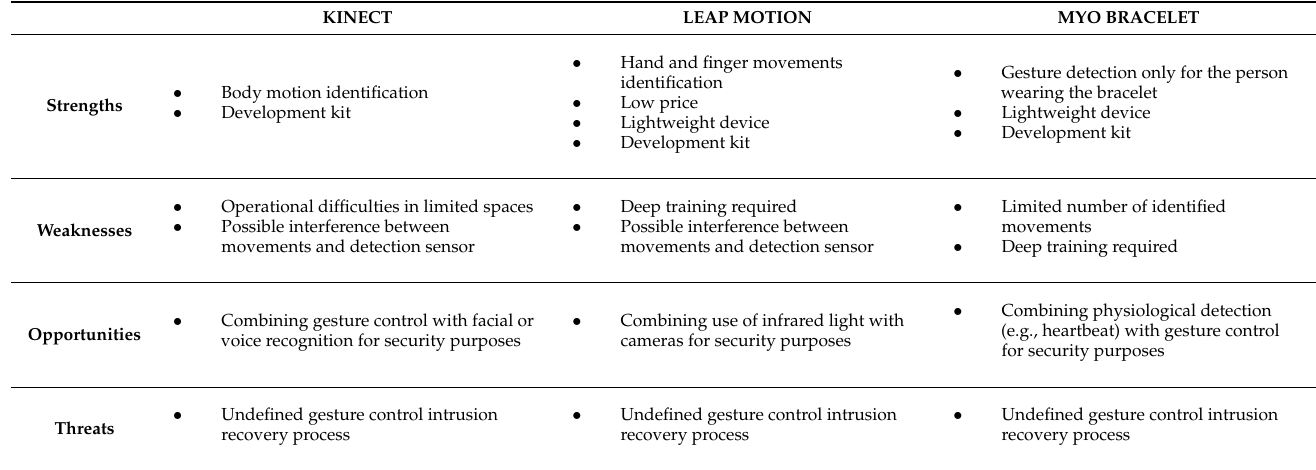
Table 1. SWOT analysis of three gesture control